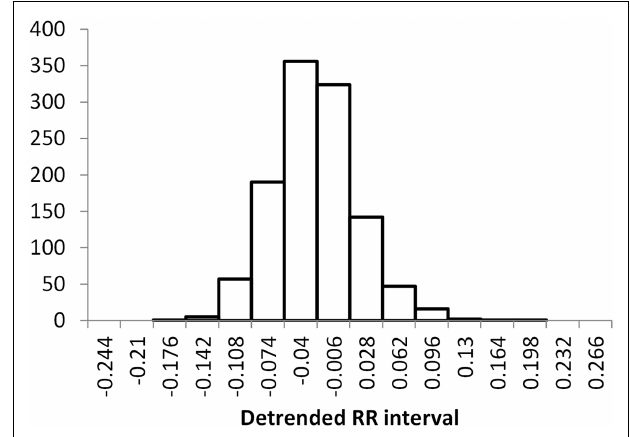
FIGURE 2 | Histograms of the detrended RR intervals for participants in the Normal group made using the same bin divisions for all data used . The vertical axis shows the count of RR intervals falling into each bin.The SD is